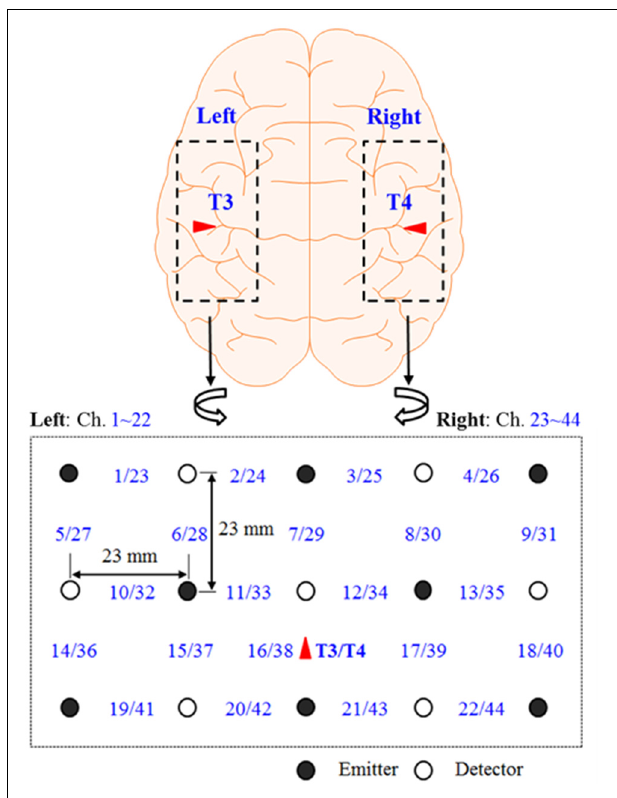
FIGURE 1 | Optode configuration: the numbers represent the measurement channels, where Chs. 16 and 38 coincide with T3 and T4 locations in the International 10–20 system (Hong and Santosa,